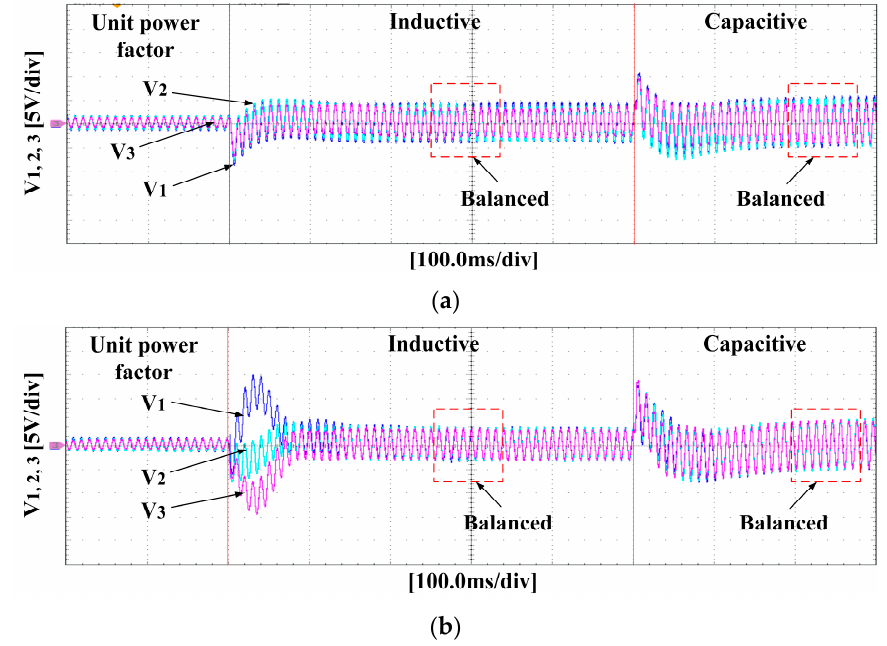
Figure 15. Experimental waveforms of the dc-link voltage of the CHBR modules under different working conditions by use of ( a ) the proposed control strategy and ( b ) the conventional control strat- egy.